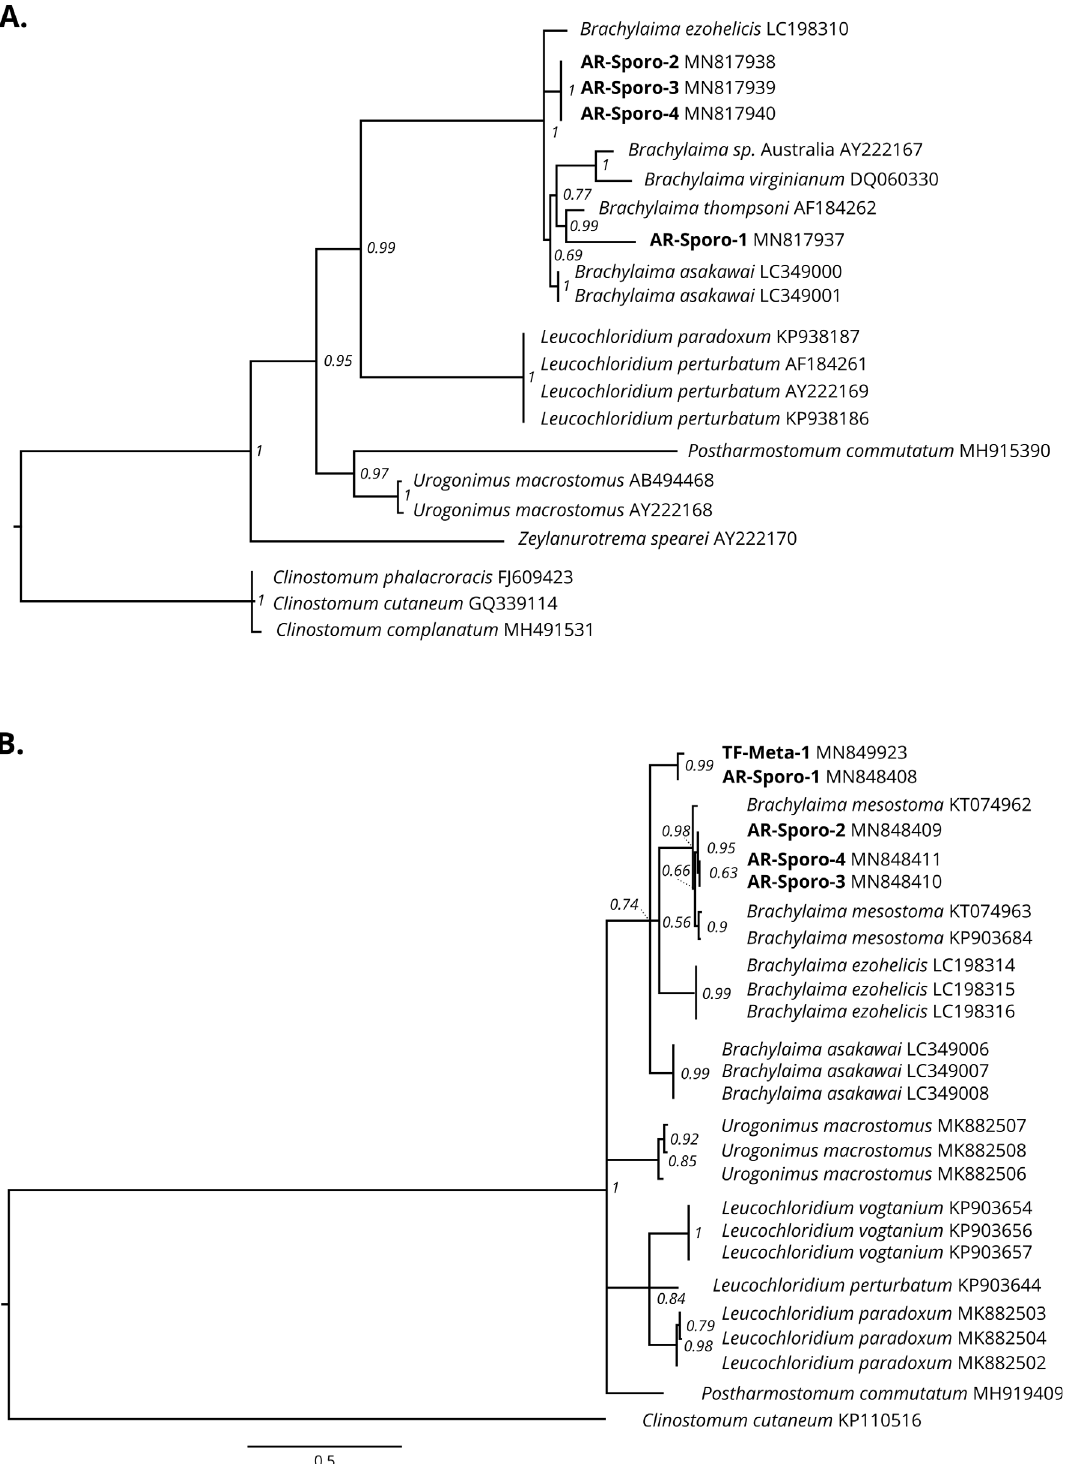
Figure 2. Fifty percent majority-rule consensus phylogram from the Bayesian inference (BI) analysis of (A) 28S rDNA, (B) mtDNA COI, and (C) both concatenated sequences of unidenti fi ed trematode specimens from two Cornu aspersum populations (in bold) and related species from the Brachylaimidae and Leucochloridiidae families. The trees are rooted using Clinostomum sp. (Family Clinostomidae) as the outgroup. Posterior probability values (in italics) are indicated near the branch nodes. Scale bars indicate the number of substitutions per nucleotide site. See Table 4 for information on taxonomy and sample origin, and Supplementary Tables 1 – 3 for information on the percentage of identity among